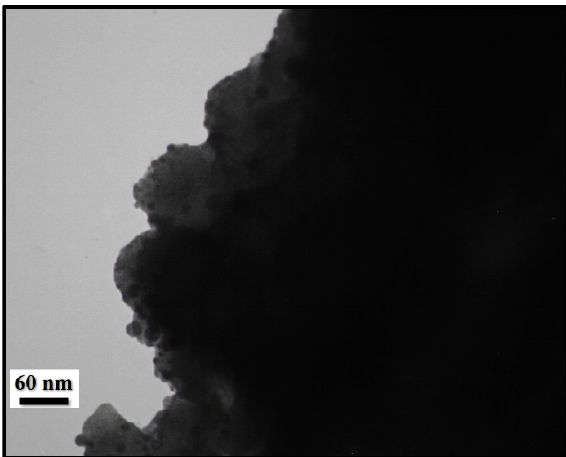
Figure 6. TEM image of SPION@CS − IL after the fifth run.